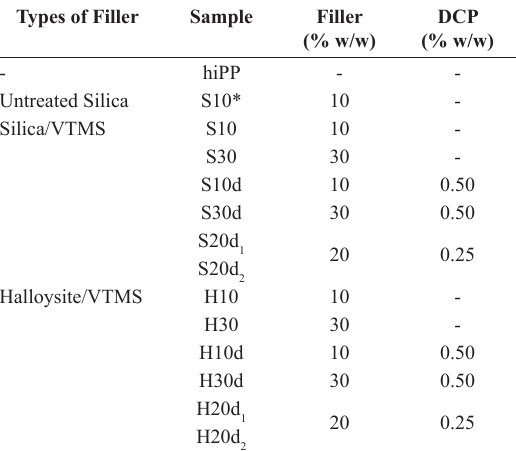
Table 1. Identification of